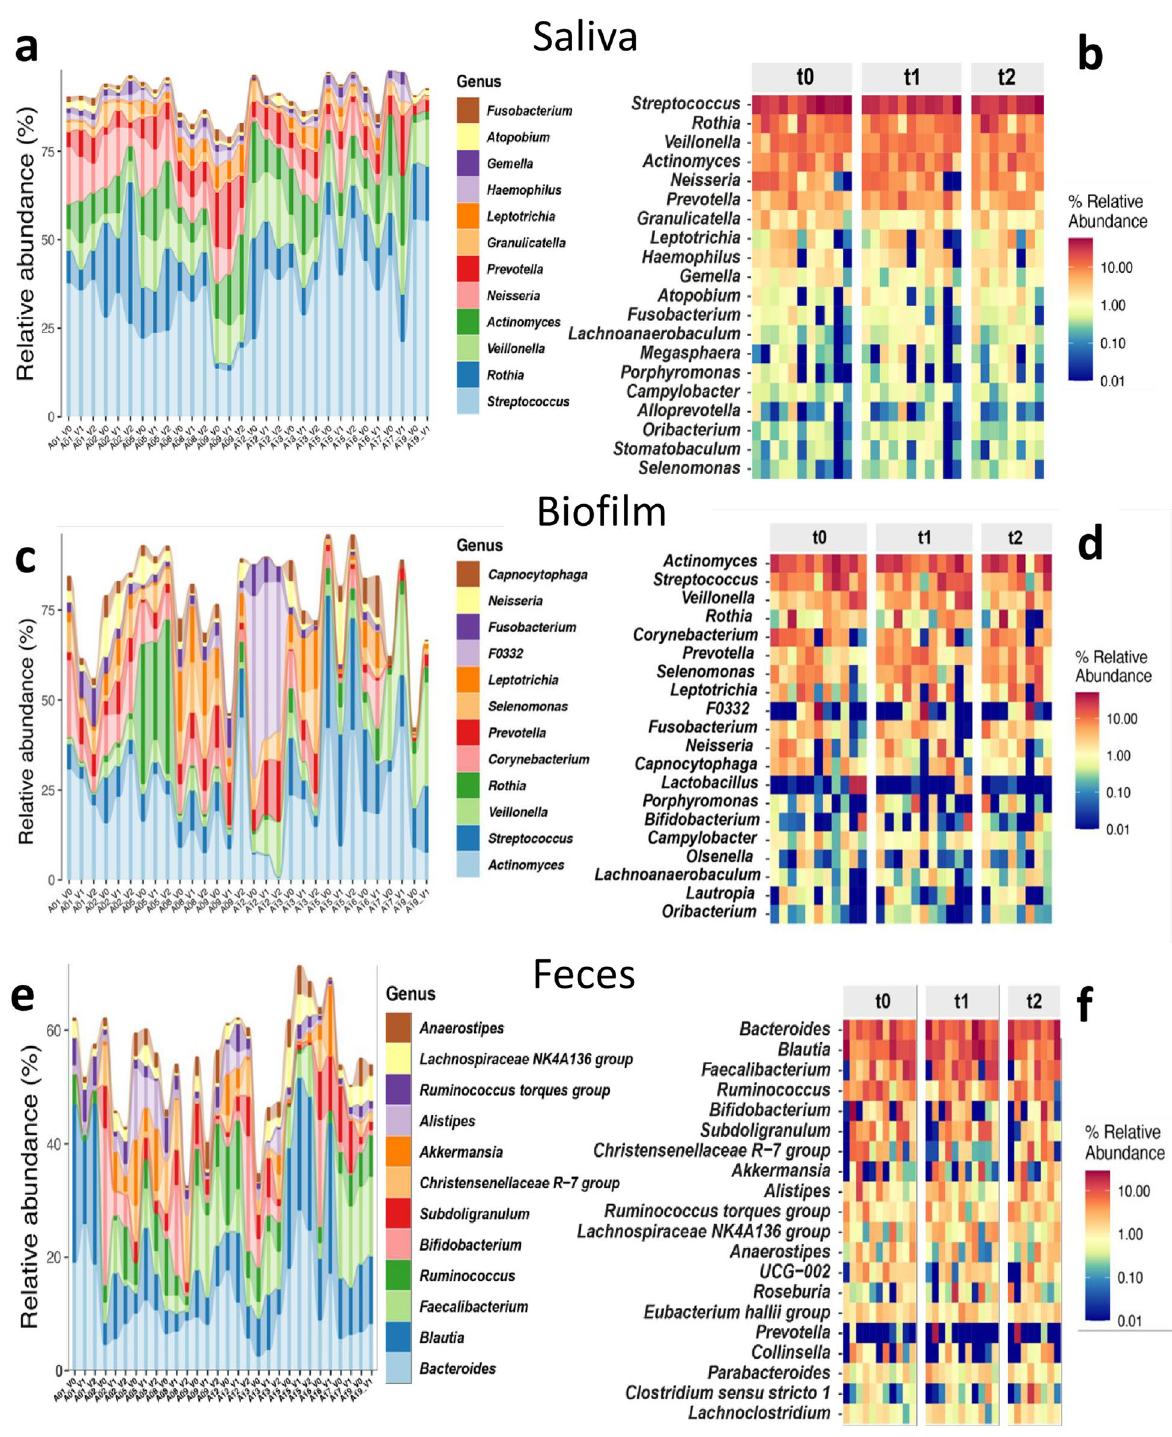
Figure 4. Changes in the oral ( a – b saliva and c – d teeth-attached biofilm) and intestinal ( e – f ) microbiome from baseline (V0, t0) to one (V1, t1) and four (V2, t2) weeks of SFOH administration. The patient-specific dynamic is presented on the left ( a , c , e ) whereas the relative abundance of each genus is presented on the right side ( b , d , f